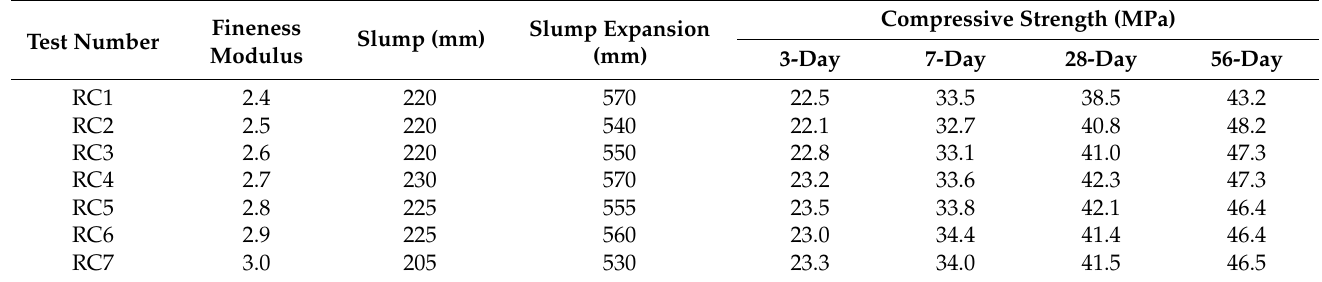
Table 10. Performance test results of river sand concrete with different fineness modulus.